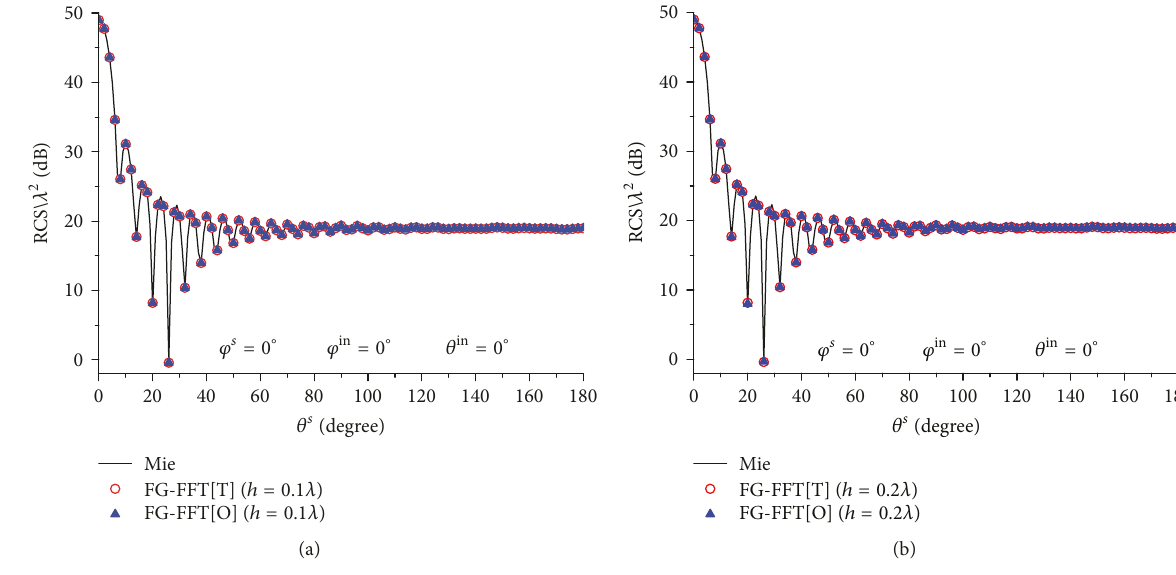
Figure 4: The bistatic RCS curves of the PEC Sphere. (a) ℎ = 0.1𝜆 ; (b) ℎ = 0.2𝜆 .